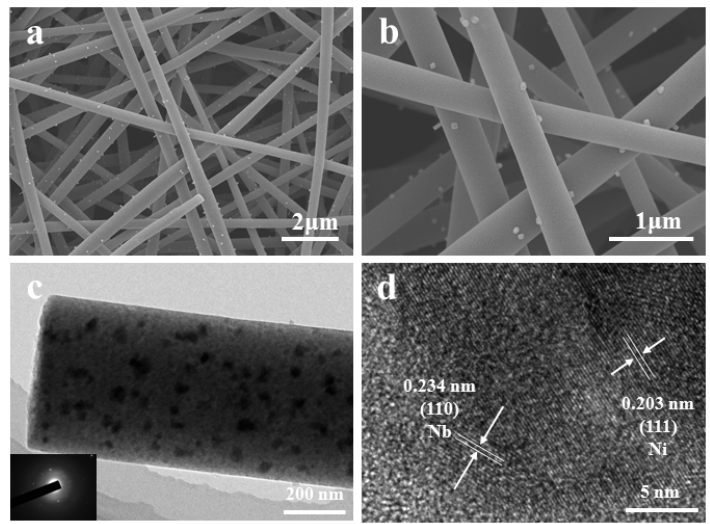
Figure 3. ( a , b ) SEM images of Nb/Ni@NC nanofibers with low/high magnification; ( c , d ) low-magnification TEM image and high-resolution TEM image of Nb/Ni@NC nanofiber.